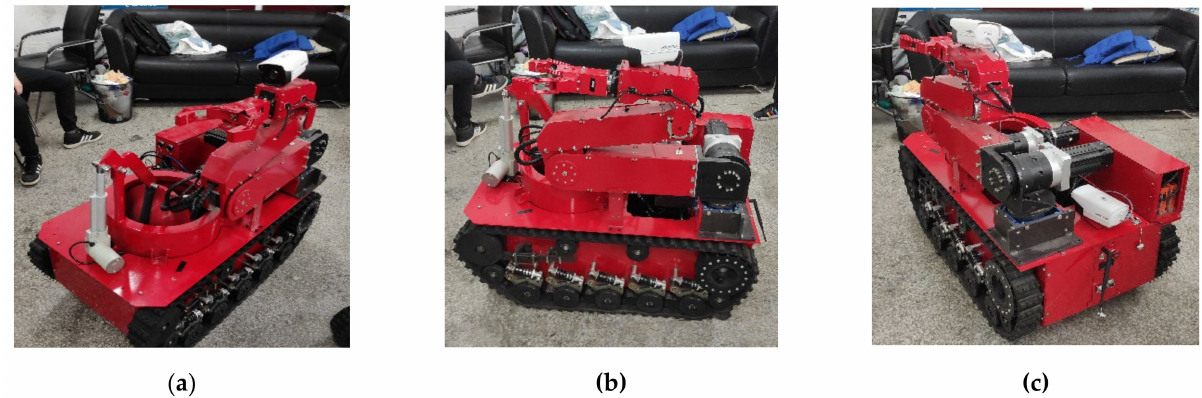
Figure 12. Robot in situ steering performance test: ( a ) Initial state of situ steering; ( b ) During situ steering; ( c ) In place intu steering end state.